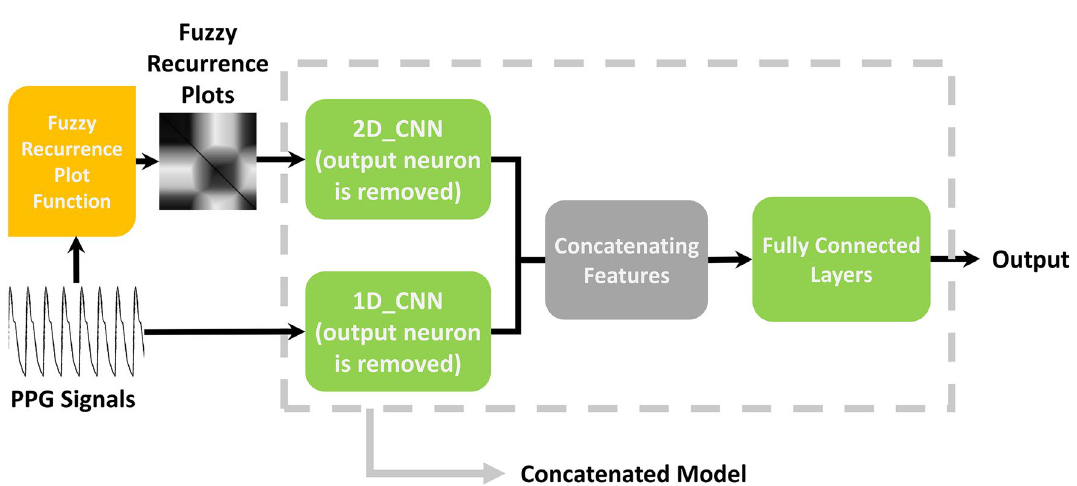
Figure 2. The complete preprocessing, feature extraction, concatenation and predicting stages of our proposed